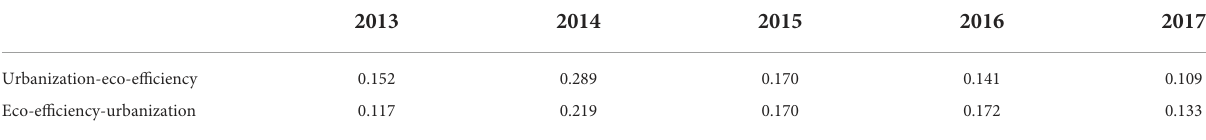
TABLE 4 Changes in bivariate Moran’s I index of agricultural counties and districts in Liaoning province over the